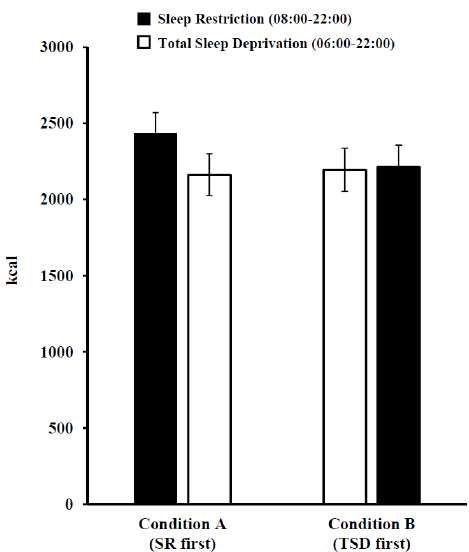
Figure 3. Mean ± SEM daily caloric intake following one night of sleep restriction (SR) and one night of total sleep deprivation (TSD). There was no significant sleep loss exposure type (SR and TSD) × condition (A and B) interaction effect ( p = 0.16), and no significant main effects of sleep loss exposure type ( p = 0.11) or condition ( p = 0.61).